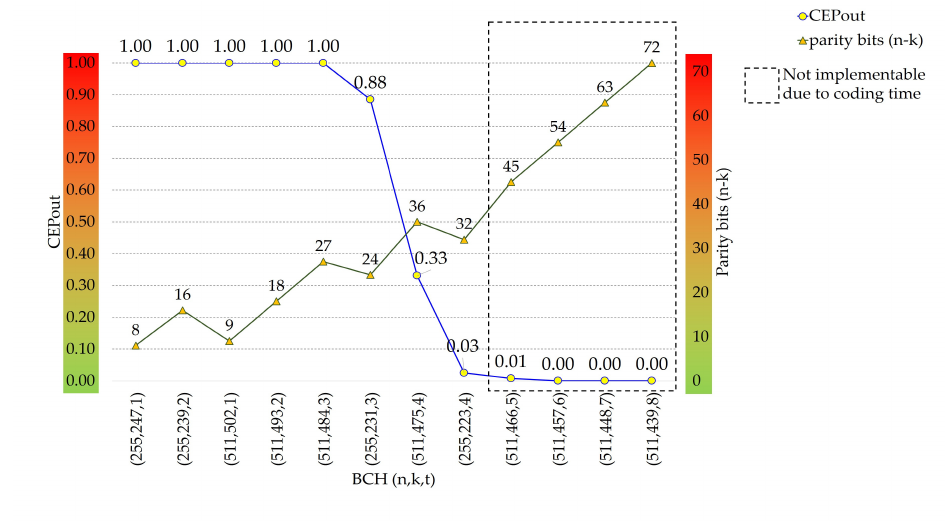
Figure 6. Comparative graph of different BCH codes with code sizes n = 255 and n = 511. As more parity bits are added, the probability of on-chip error decreases. The dotted box contain ECCs that do not allow the encoding of the information in real-time for the used